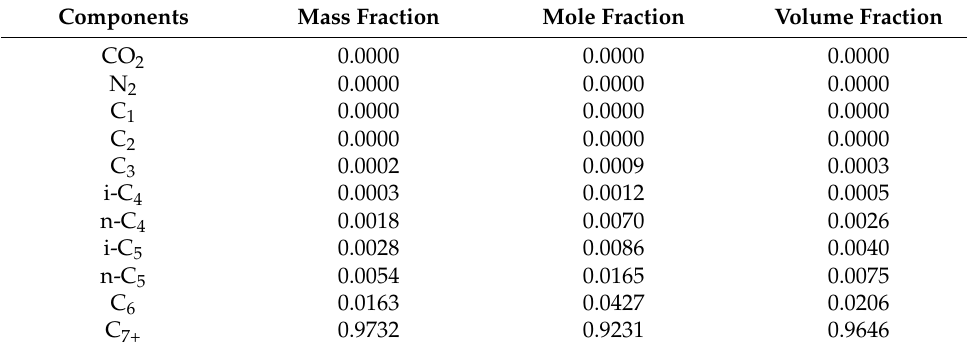
Table 3. Composition of crude